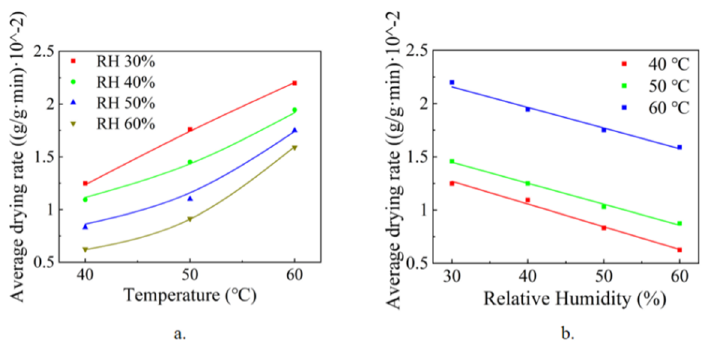
Figure 6. Average drying rate versus ( a ) temperature and ( b ) relative humidity.